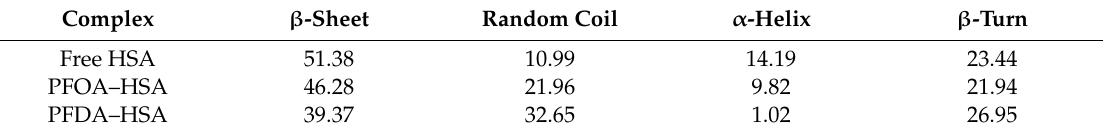
Table 3. Secondary structure analysis (infrared spectra) for free HSA and its drug complexes at pH 7.4.